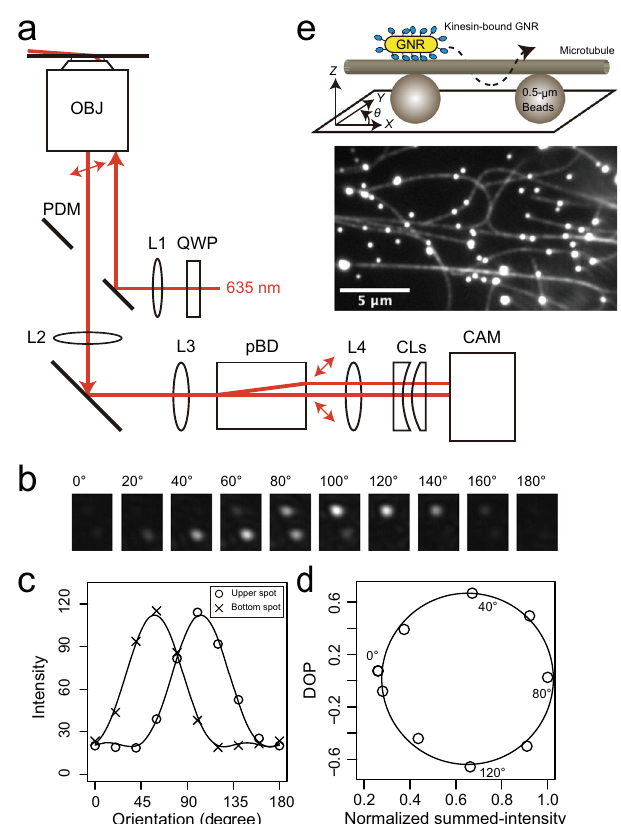
Fig. 1 GNR motility assay. a Schematic drawing of the optics for the gold nanorod (GNR) motility assay. OBJ objective lens, PDM perforated dichroic mirror, QWP quadruple wave plate, pBD polarizing beam displacer, CL cylindrical lens, CAM CMOS camera, L lens. b – d Calibration for polarization measurements. b Series of pairs of scattered-light spots of microbeads (0.1 μ m) modulated by a polarizer, which was located in front of L3, for emulating GNR spots with various orientations in the plane. c Intensity pro fi les of a pair of scattered-light spots ( I bottom , I upper ) shown in the upper images. The plots of I bottom and I upper were fi tted by intensity functions of the GNR orientation (Materials and Methods). d Degree of polarization (DOP), ( I bottom − I upper )/( I bottom + I upper ) as a function of the normalized summed-intensity of two scattered-light spots, ( I bottom + I upper ). e Schematic drawing of the GNR motility assay in which a kinesin-coated GNR moves along a microtubule suspended with fl uorescent microbeads (0.5 μ m) attached to a glass substrate. Fluorescence image of Cy5-labeled microtubules suspended on fl uorescent microbeads. The bright spots are the fl uorescent